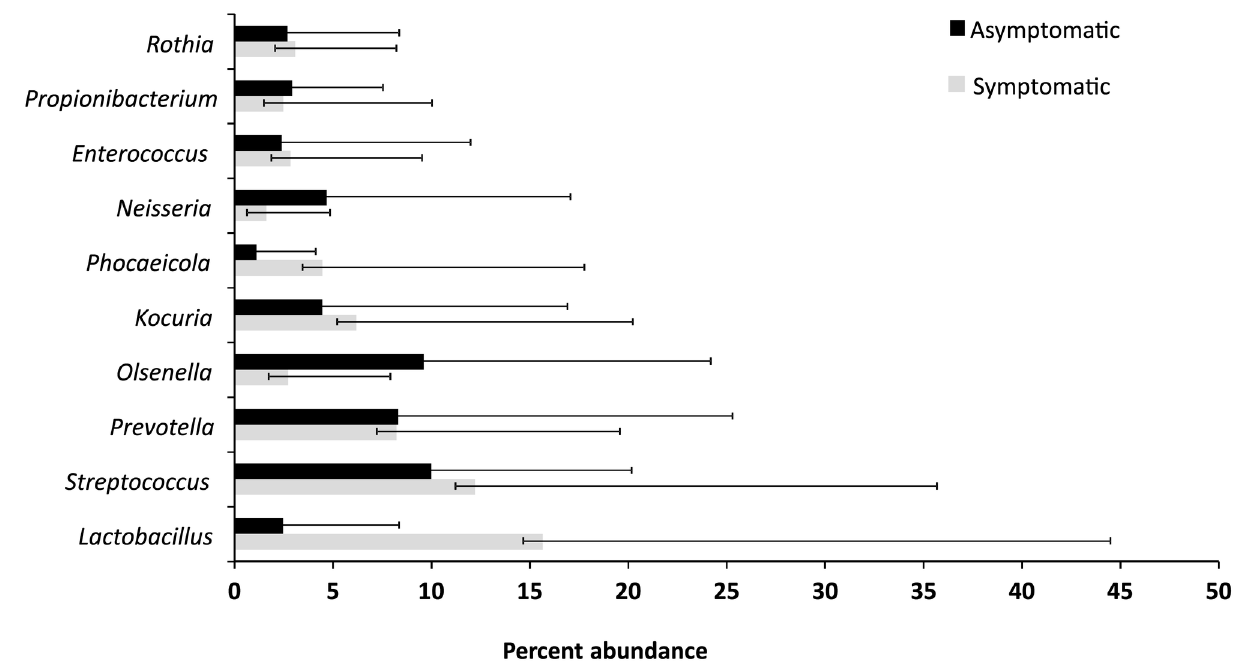
Figure 4. Depicts the mean percentage abundance of the top ten bacterial taxa contributing to more than 52.6% dissimilarity among the two types of samples (symptomatic = black, asymptomatic = grey) from previously root-filled teeth as identified by Bray-Curtis model of SIMPER analysis.